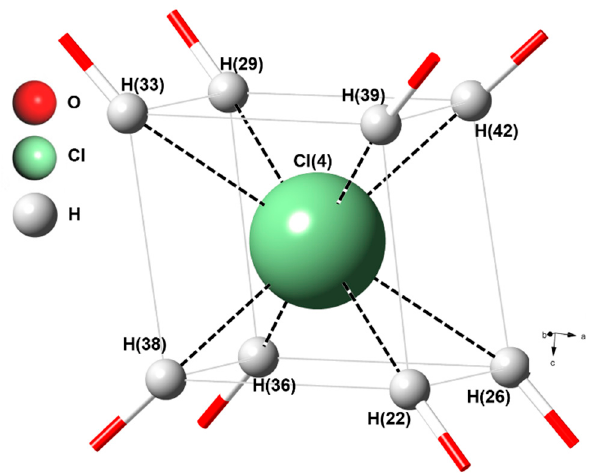
Figure 5. The optimized hydrogen bonds structure surrounding the Cl in the tunnel site of the newly proposed Ge ‐ akaganéite model after DFT ‐ D calculation. The hydrogens form the twisted cubic structure around the Cl atom (CN (coordination number) = 8). Hydrogen bond lengths of Cl(4) are summarized in Table S4. Hydrogen bonds are represented as dashed lines. Table 4. Calculated bond lengths (Å) of the Ge ‐ tetrahedra in the tunnel site after DFT ‐ D calculation for the proposed model.